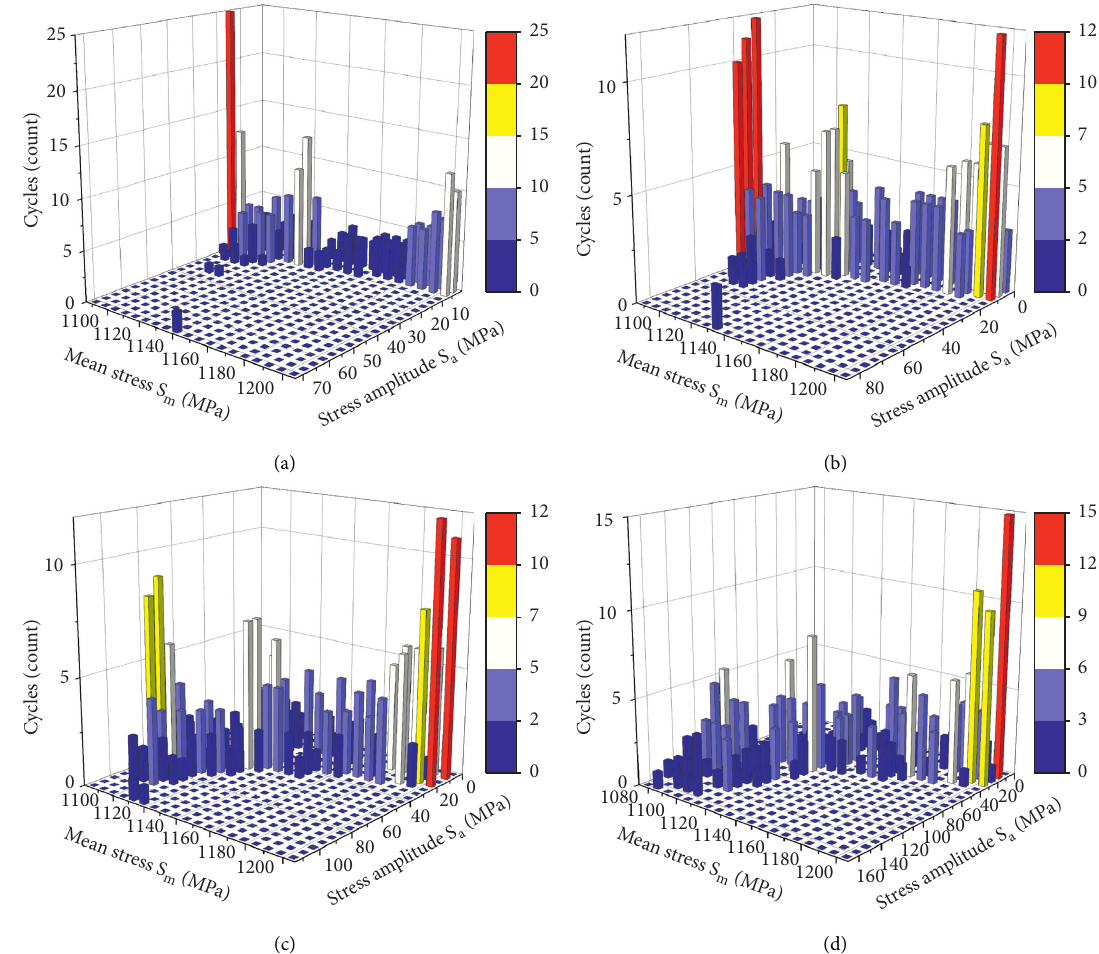
Figure 7: Rain flow counting results for the elastic rail clip with a wavelength of 50mm at different rail corrugation amplitudes: (a) 0.05mm;